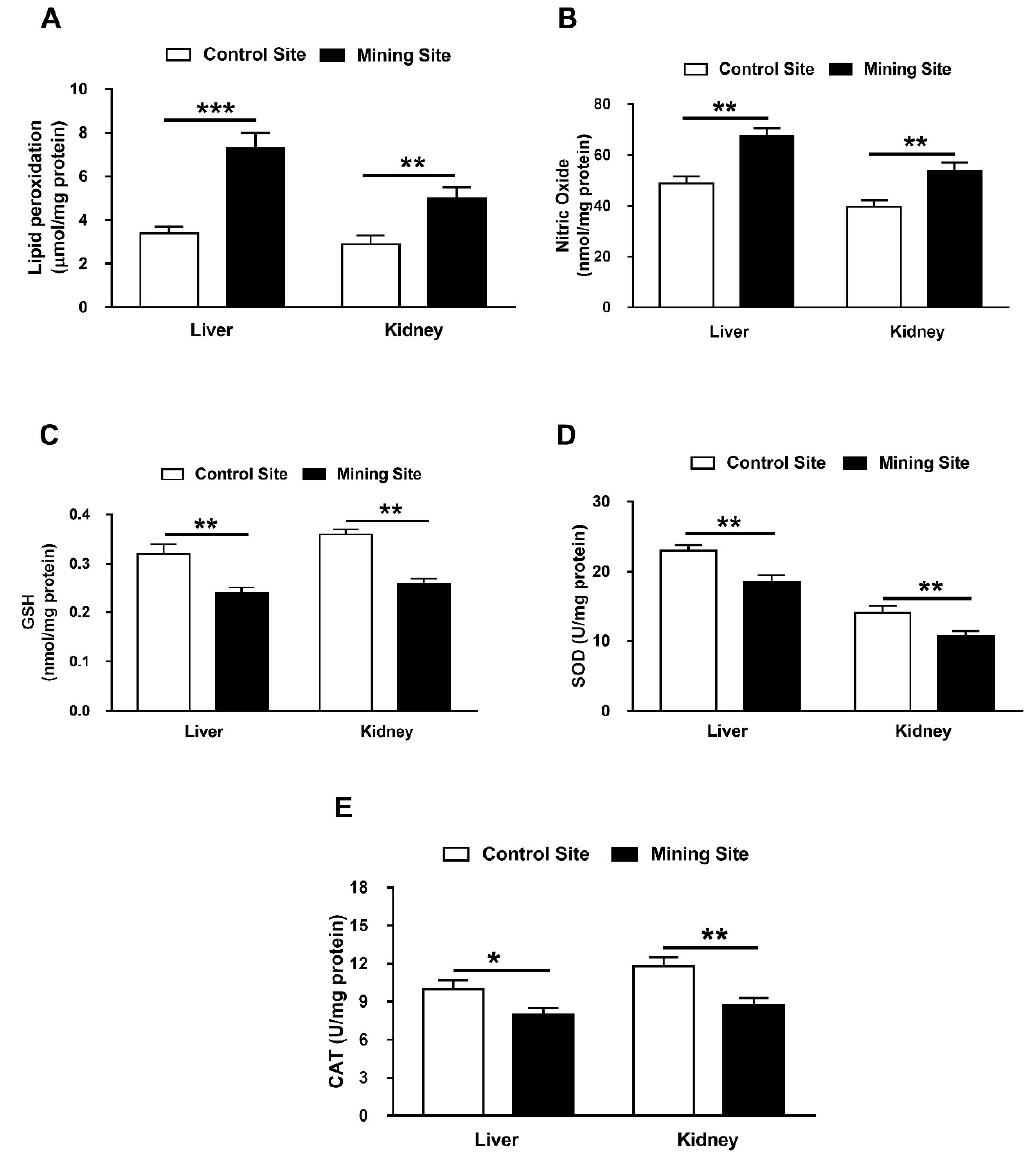
Figure 7. E ff ect of mining activities on oxidative stress and antioxidants in liver and kidney of G. nanus . Animals from the mining site showed an increase in ( A ) lipid peroxidation and ( B ) nitric oxide, and decreased ( C ) GSH, ( D ) SOD, and ( E ) CAT in liver and kidney. Data are means ± SEM, ( n = 8). * p < 0.05, ** p < 0.01 and *** p < 0.001.